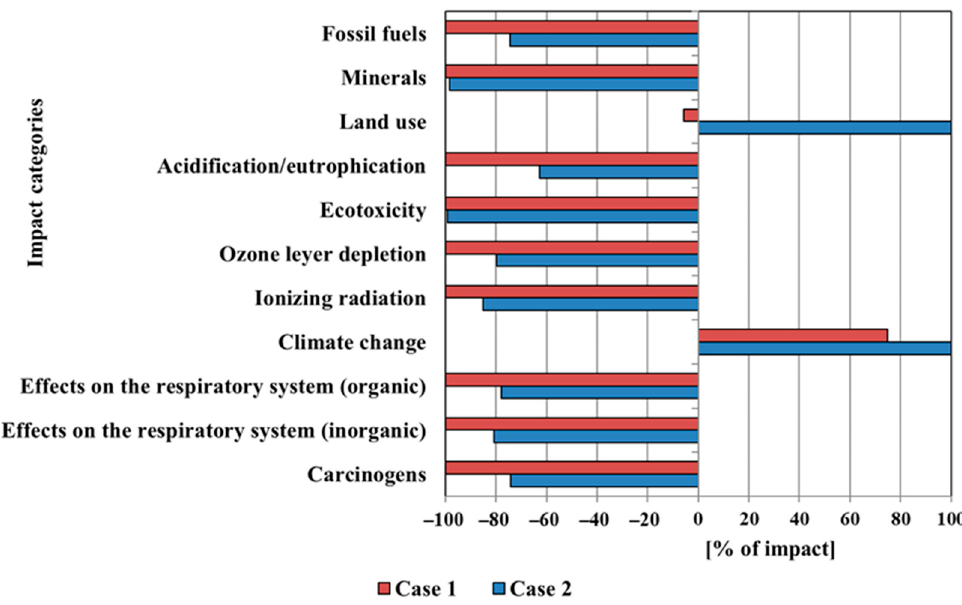
Figure 5. The results of a comparative analysis of generating 1 MWh of electricity from biogas obtained from raw materials in Case 1 and Case 2 in the life cycle for individual impact categories under the Eco–Indicator 99 method (characterization).